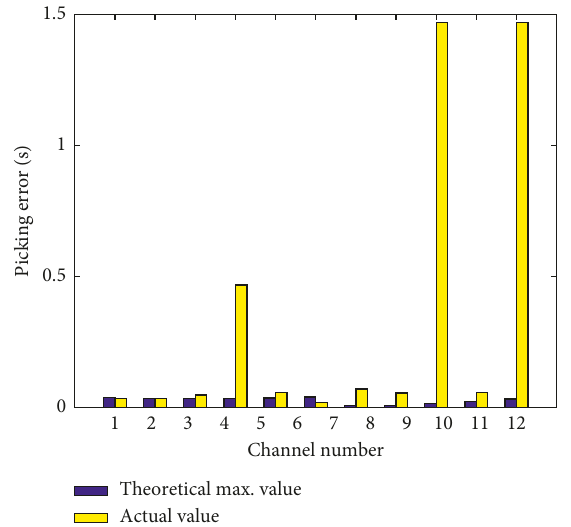
Figure 12: Comparison histogram of theoretical maximum value and actual